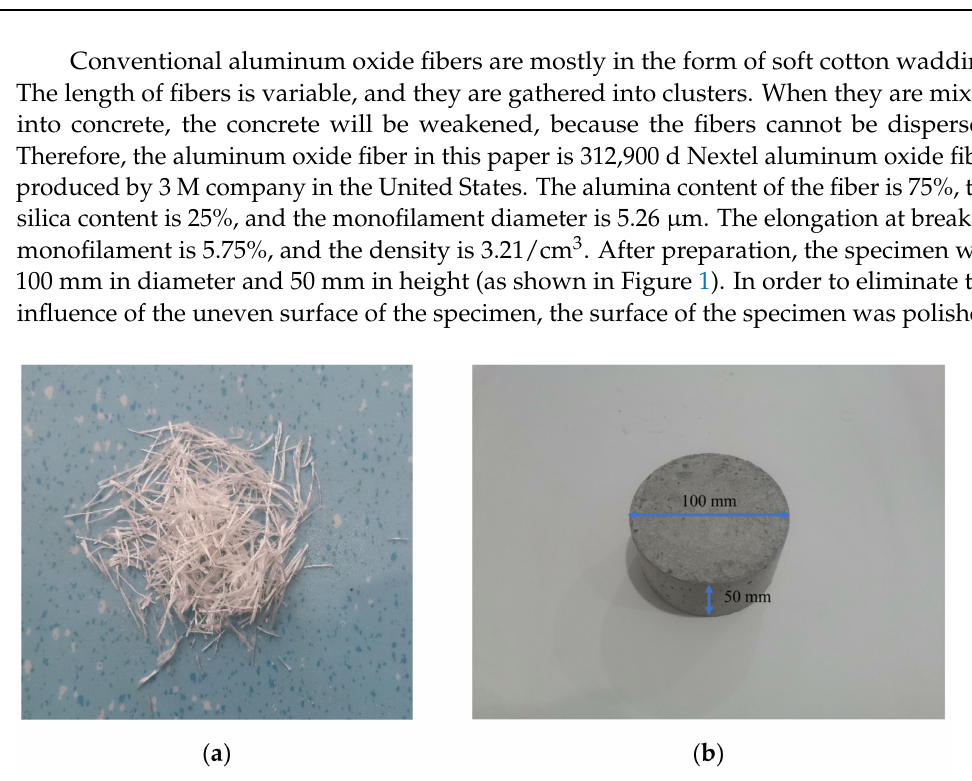
Figure 1. Raw materials for specimen production and samples after curing ( a ) 312,900 D Nextel alumina fiber; ( b ) aluminum oxide fiber-reinforced